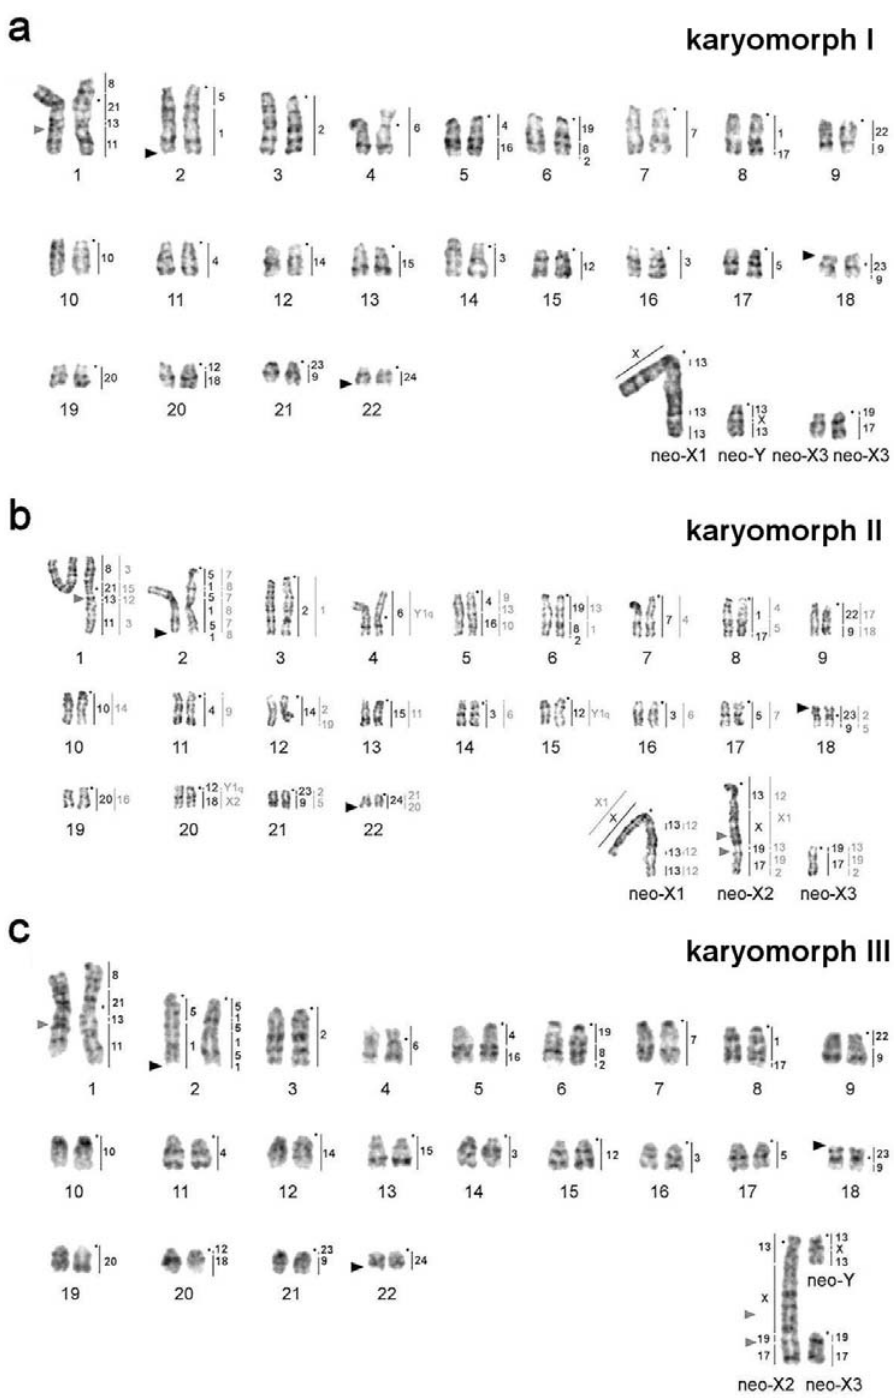
Figure 1. GTG-banded karyotype of L. m. vinogradovi : ( a ) LMAN10m, ( b ) LMAN0f [10], ( c ) LMAN5f. Black dots mark the position of centromeres. Vertical black bars mark the localization of Microtus agrestis (MAG) chromosome painting probes, vertical grey bars mark the localization of Dicrostonyx torquatus (DTO) painting probes. Numbers along the vertical lines correspond to chromosome numbers of M. agrestis and D. torquatus . Black triangles indicate sites of localization of ribosomal DNA clusters. Grey triangles indicate localization of the largest interstitial telomeric block.